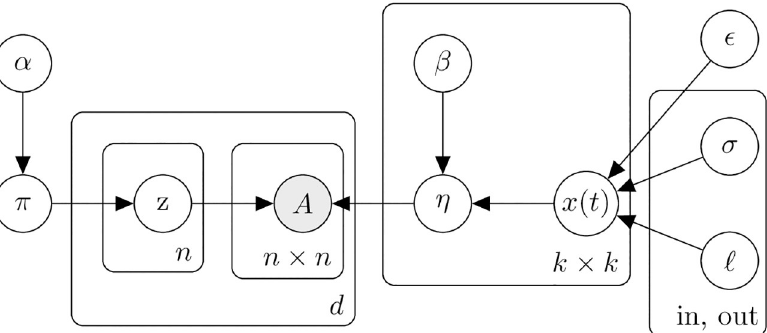
Fig 2. Plate diagram for the T-SBM. η is an time-evolving edge probability matrix governed by 1) a latent Gaussian process x ( t ) shared across community pairs and 2) a coefficient β that captures variations of specific community pairs.